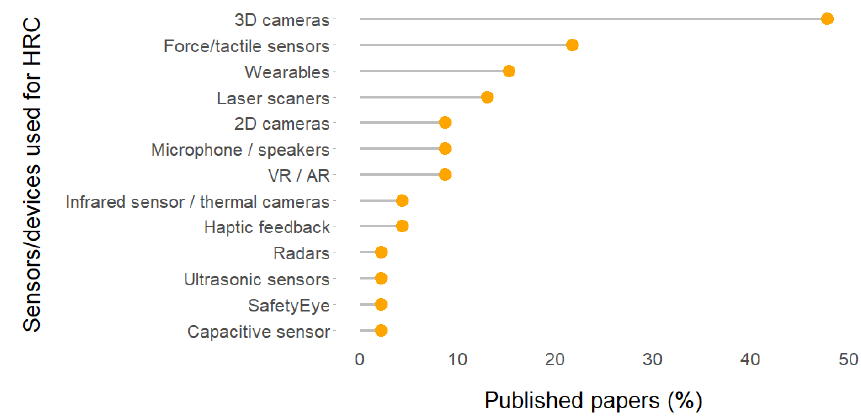
Figure 5. Percentage of different kinds of sensors/devices used for